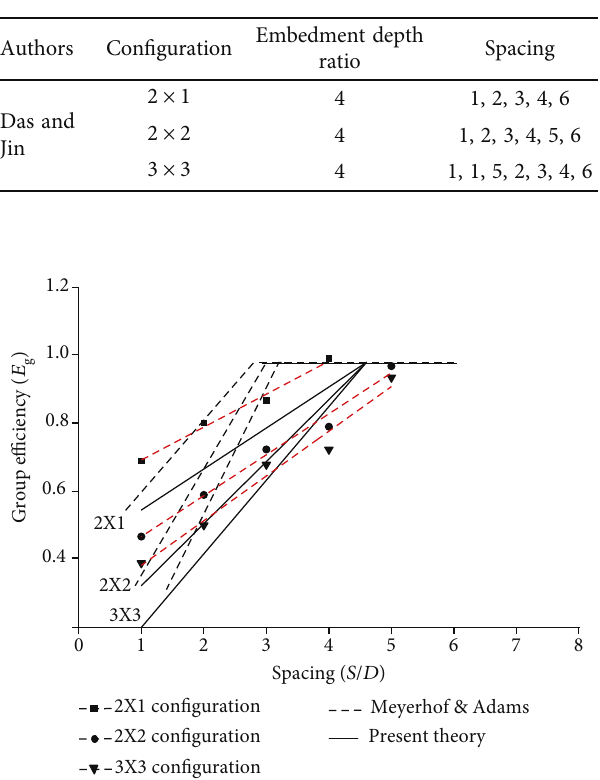
Table 3: Group anchor con fi gurations.